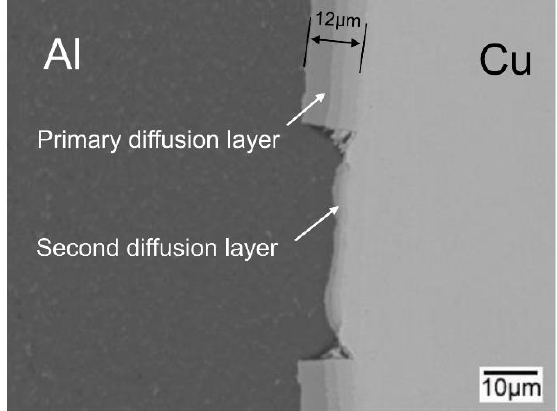
Figure 6. Microstructure (BSE image) of the Cu/Al clad sheet interface after multi-pass rolling and annealing (clad sheet thickness: 4 mm).